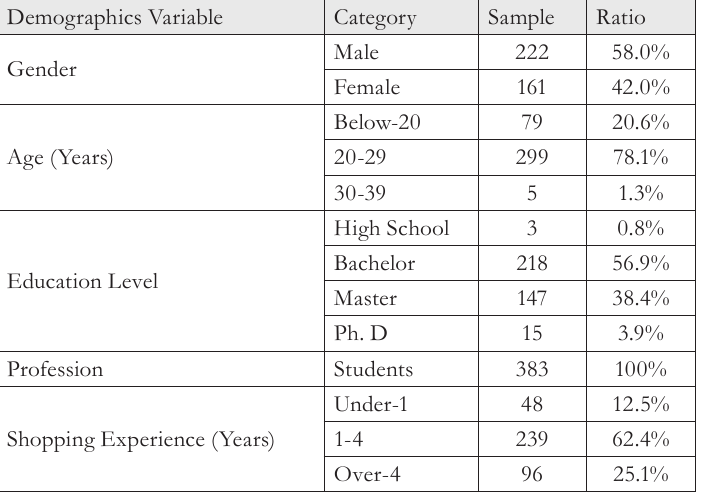
Tab. 1 - Respondent profile (n=383). Source: Authors